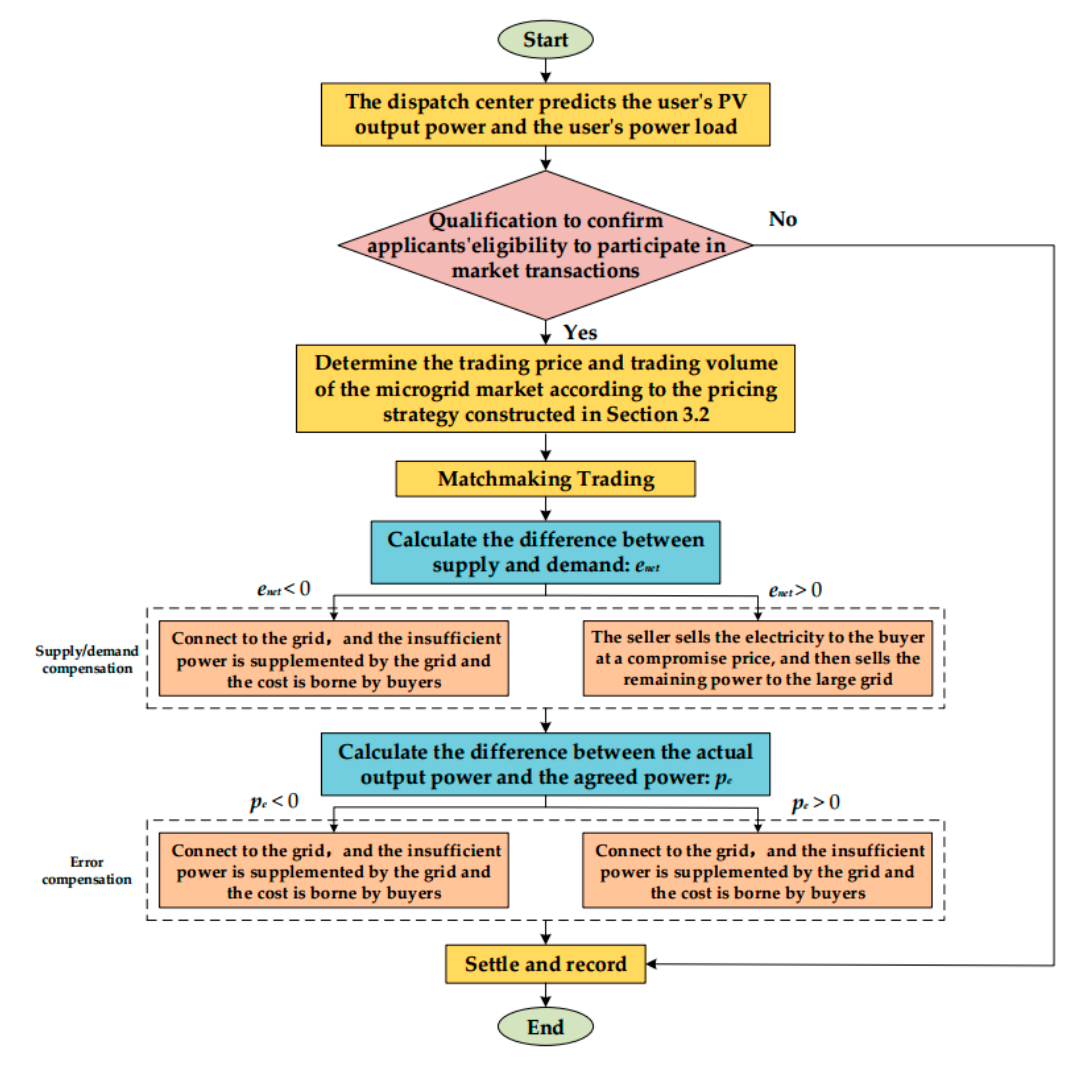
Figure 3. Transaction flow. Table 8. User power load (kW ·